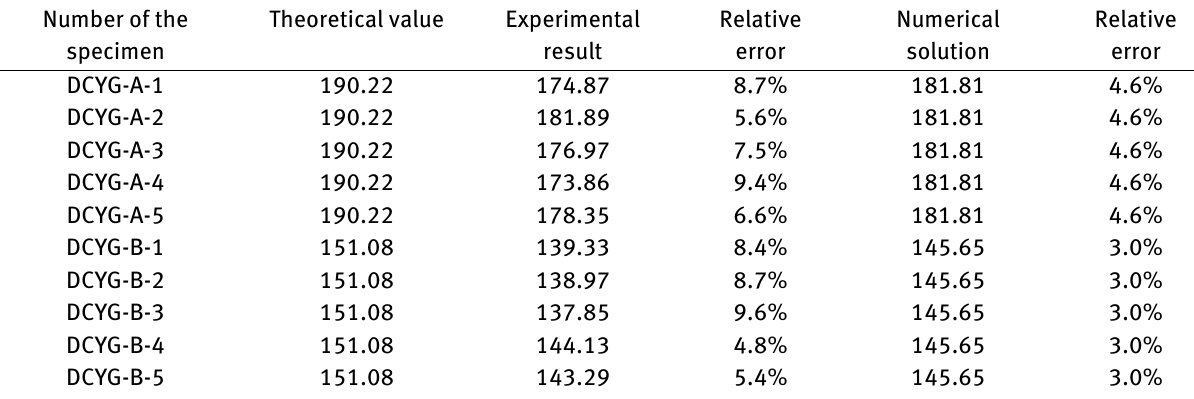
Table 5: Comparison of safe bearing capacities of axial compression columns (unit: kN). Number of